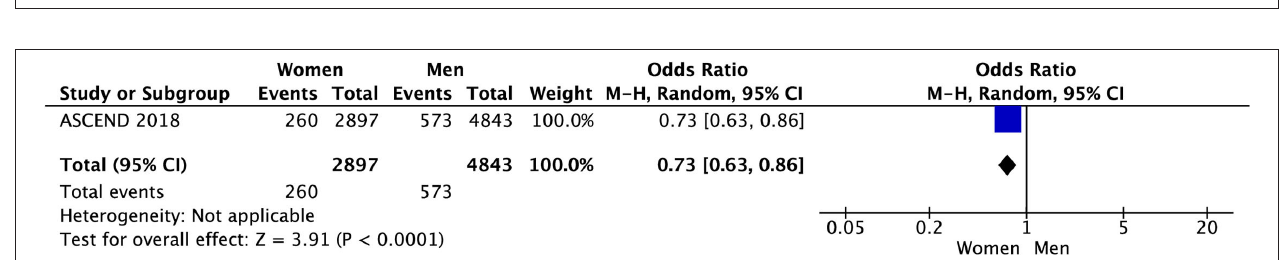
FIGURE 13 | Cardiovascular disease in women and men taking aspirin.